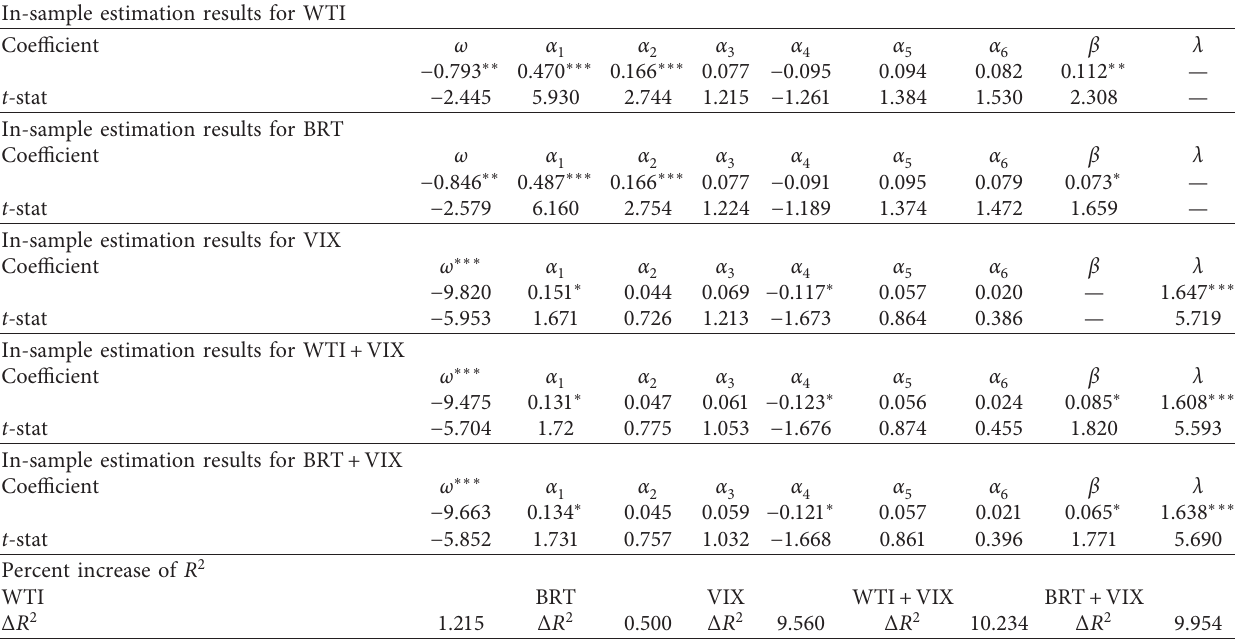
Table 2: In-sample estimation